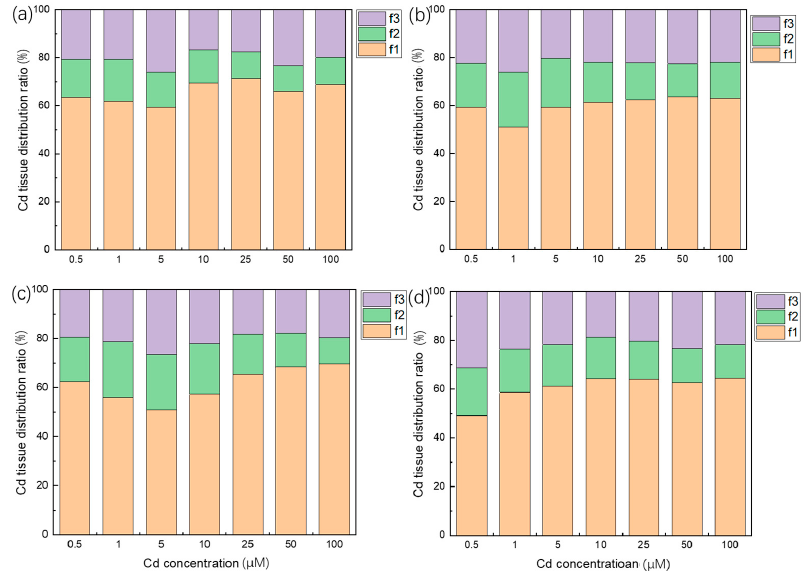
Figure 5. Distribution ratio of Cd content of each fraction of subcellular, f1: cell wall fraction, f2: organelle fraction, f3: soluble fraction, under different Cd concentration treatments ( a ) hydroponic culture for 10 days, ( b ) hydroponic culture for 20 days, ( c ) hydroponic culture for 30 days, ( d ) hydroponic culture for 40 days.